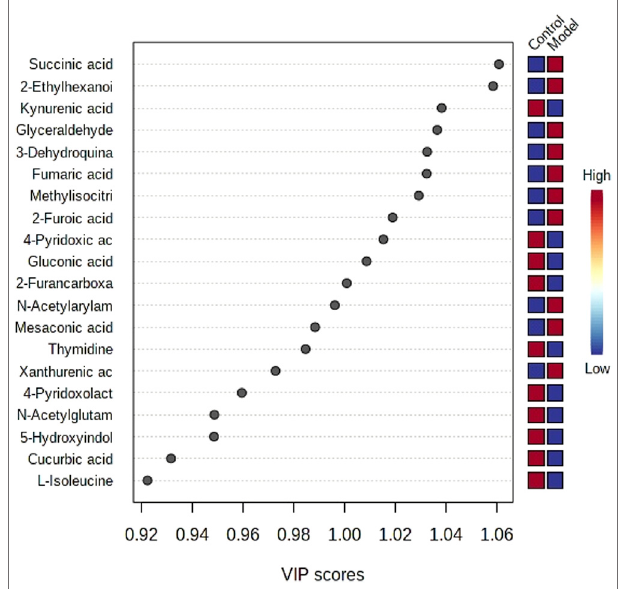
FIGURE 3 | Top signi fi cant features of the metabolite markers based on the VIP projection.